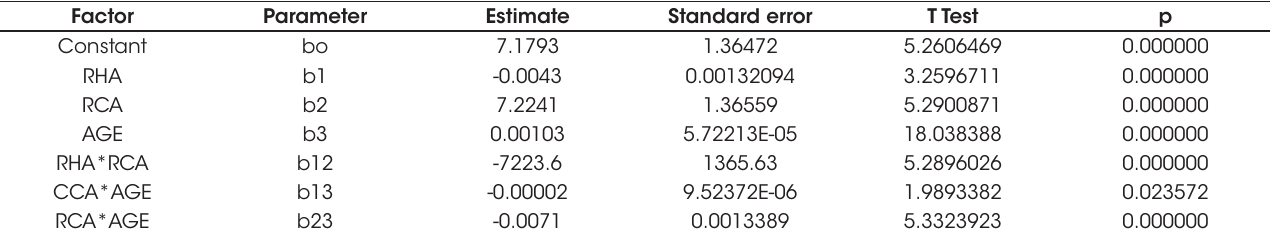
Significant parameters for the factors analyzed considering shrinkage